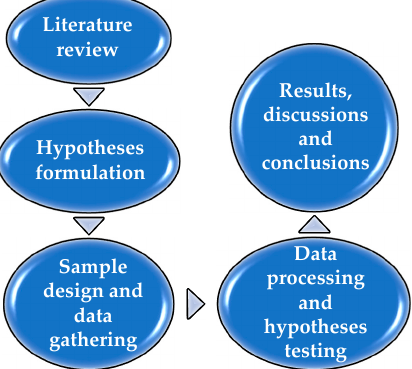
Figure 2. Research process phases. Source: own construction.